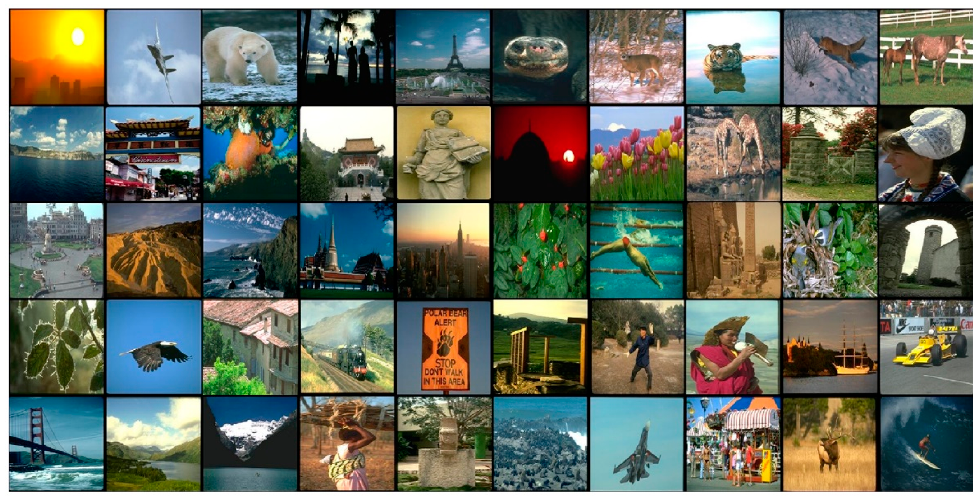
Figure 9. Sample image from each category in Corel-5k dataset.